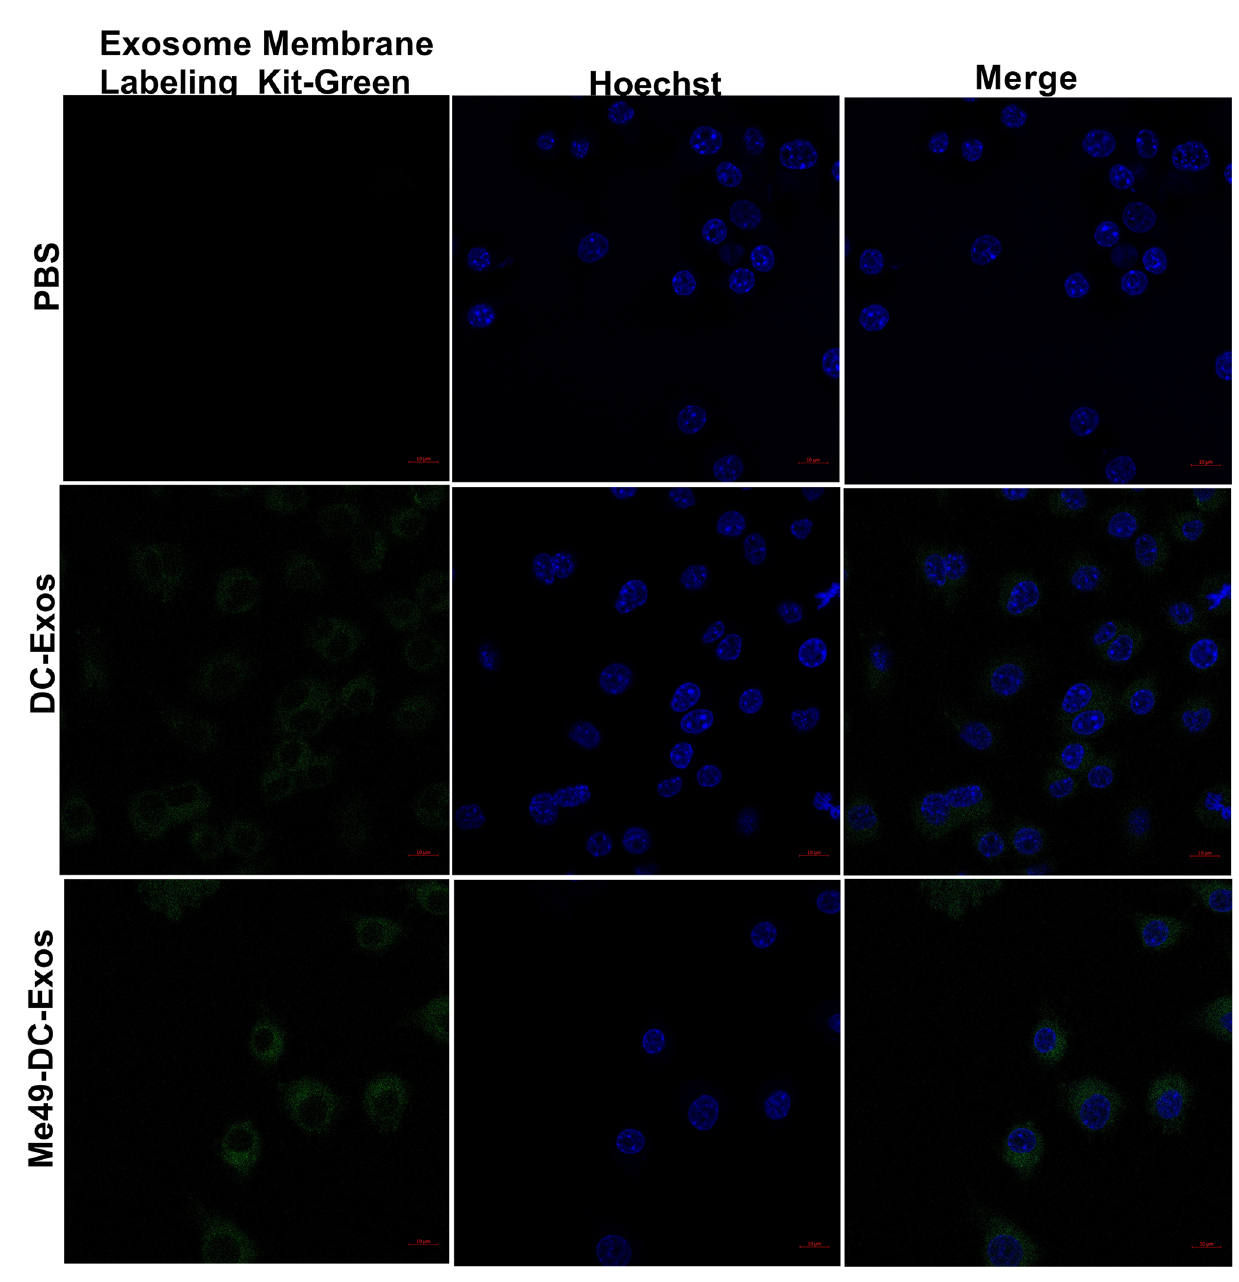
FIGURE 3 | Veri fi cation of exosome uptake by macrophages. PBS control without exosomes, Mem Dye-Green labeled DC-Exo and Me49-DC-Exo were added to macrophage Raw264.7 and observed under laser confocal microscope. In the fl uorescence microscope image, Mem Dye-green and Hoechst was used to label exosomes (Green) and macrophage nuclei (blue). Each experiment was repeated three